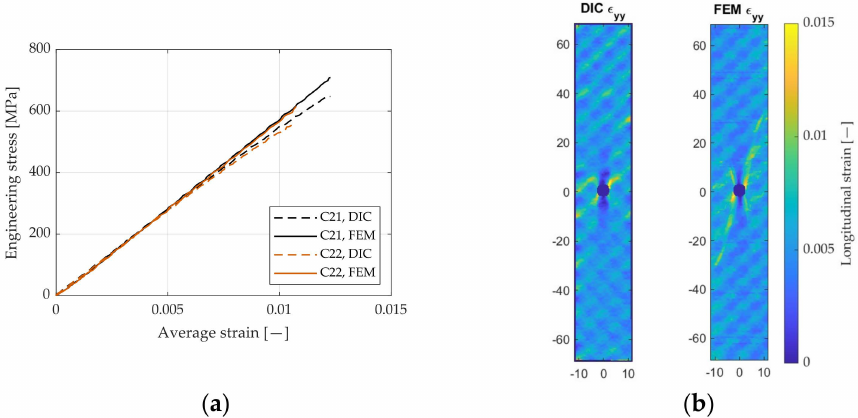
Figure 7. ( a ) Comparison between experimentally and numerically determined stress and strain curves; ( b ) Example of a comparison between experimentally (left) and numerically determined longitudinal strain maps for Specimen C22.